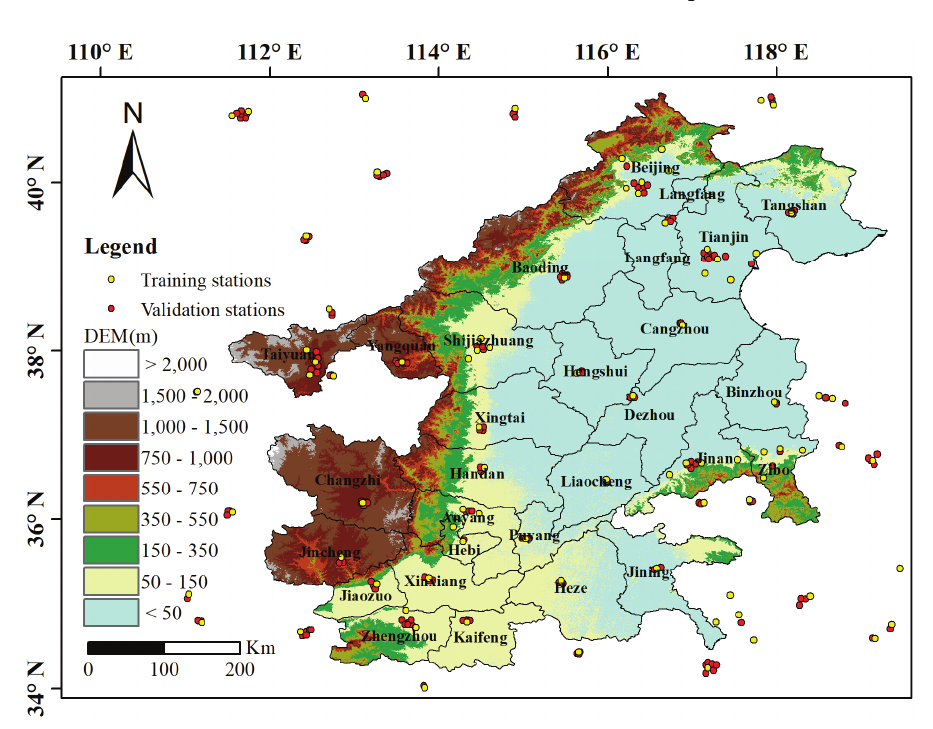
Figure 1. Study area and spatial distribution of ground PM 2.5 observation stations.